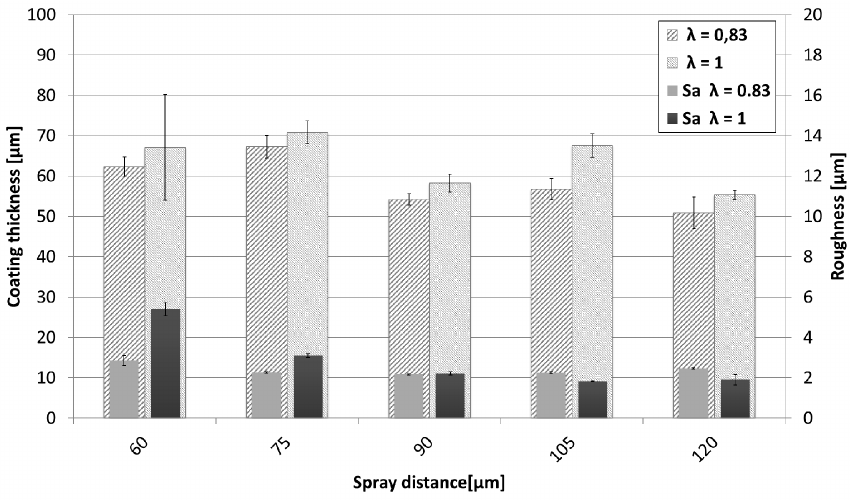
Figure 6. Comparison of coating thickness and roughness values of the NiCr coatings sprayed at di ff erent spray distances and λ values.